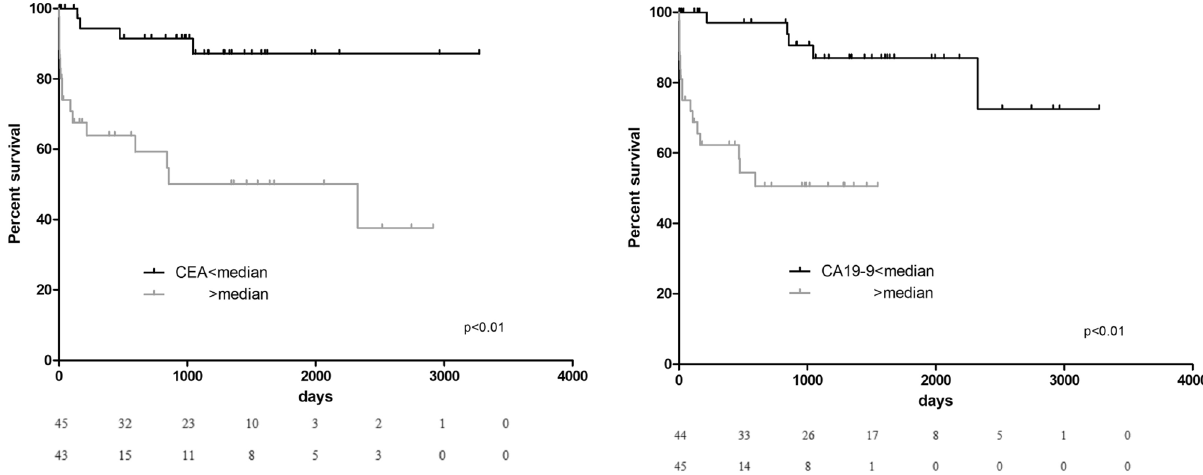
Figure 2. Kaplan Meier curves, showing survival rates according to CEA and CA-19.9 over median values.